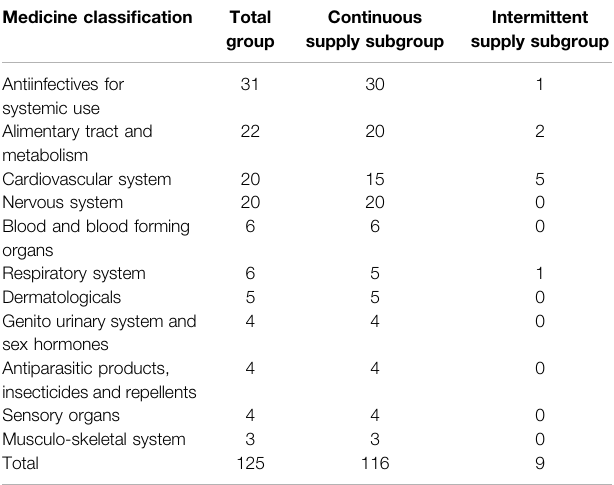
TABLE 1 | The number of LPCMs for different kinds of dieases and there distribution in each group.